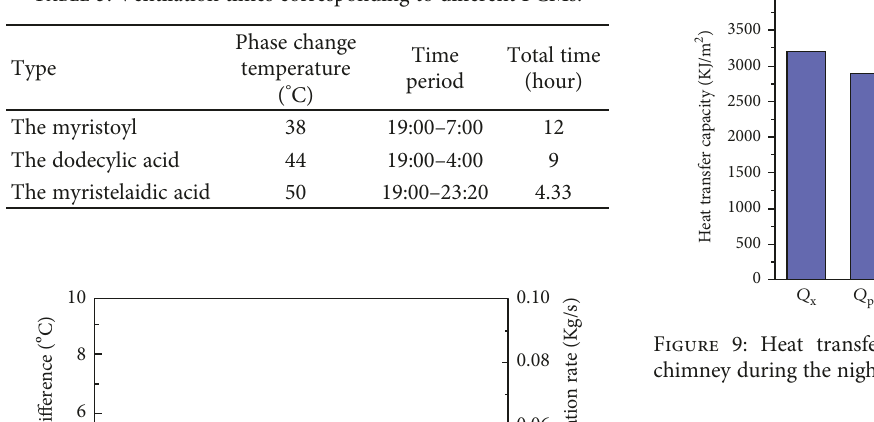
Table 3: Ventilation times corresponding to di ff erent PCMs.